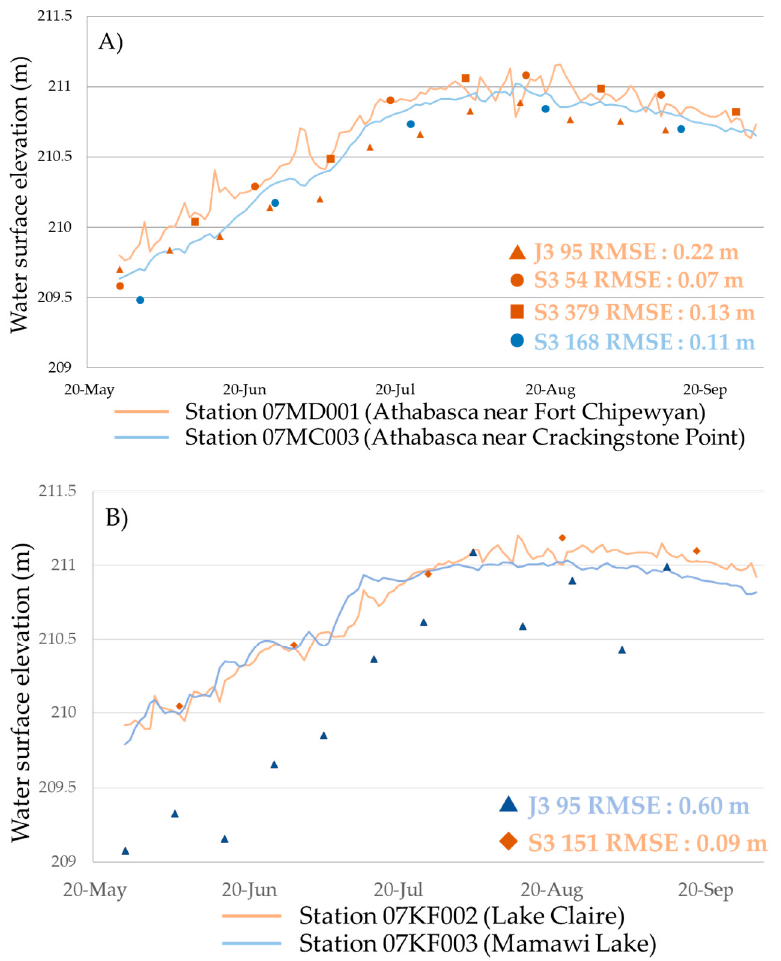
Figure 9. Water levels from altimetric instruments: ( A ) Sentinel-3 and Jason-3 for Lake Athabasca; ( B ) Sentinel-3 for Lake Claire and Jason-3 for Mamawi Lake.